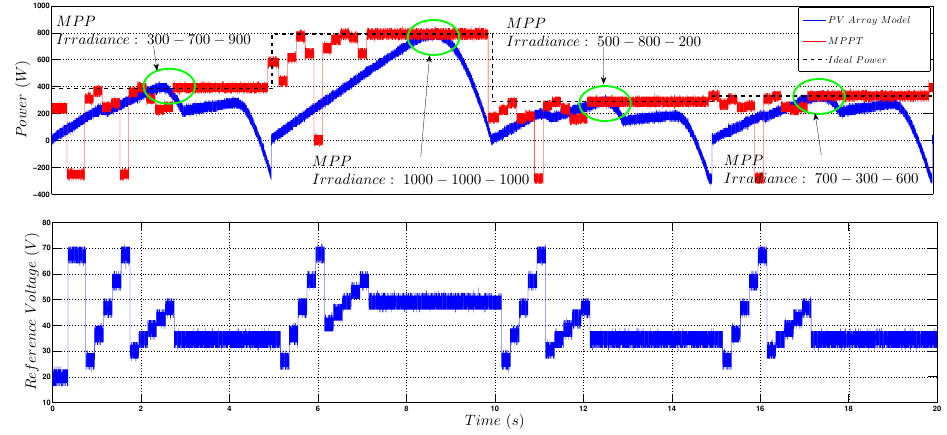
Figure 20. MPPT of the array of PV panel STP245S with curves of the model generated by the